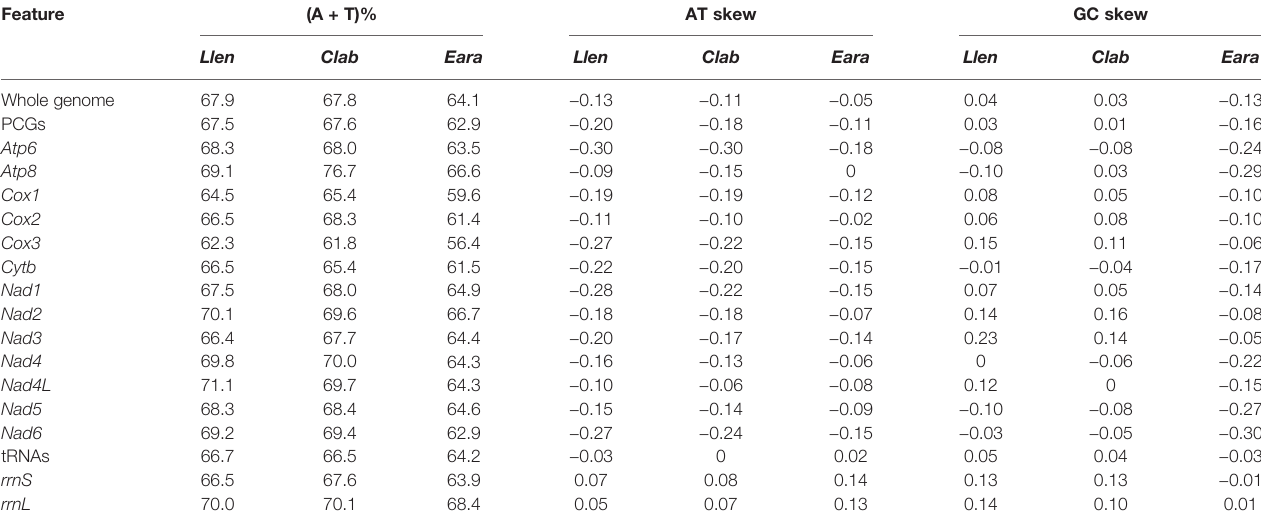
TABLE 3 | List of AT content, AT skew, and GC skew of Lentigo lentiginosus ( Llen ), Canarium labiatum ( Clab ), and Euprotomus aratrum ( Eara ). Feature (A + T)% AT